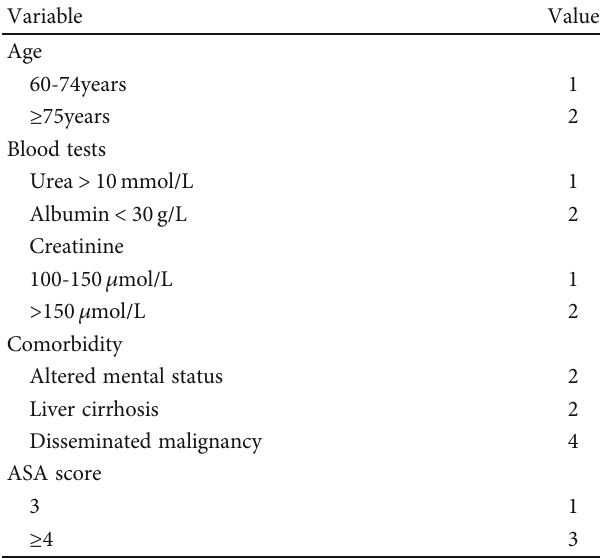
Table 3: Characteristics of the elderly